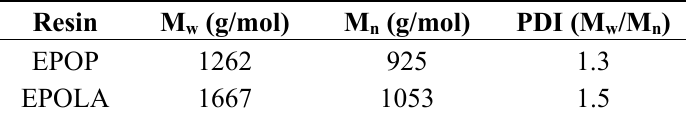
Figure 2. Molecular Weight Distribution Curves of EPOP and EPOLA. Table 2. Molecular weights, PDI of EPOP and